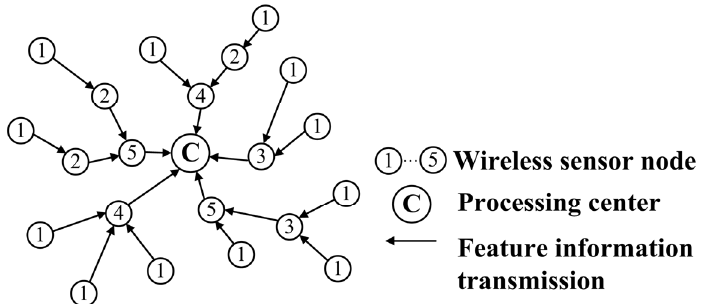
Figure 1 . Computing scenario of centralized learning